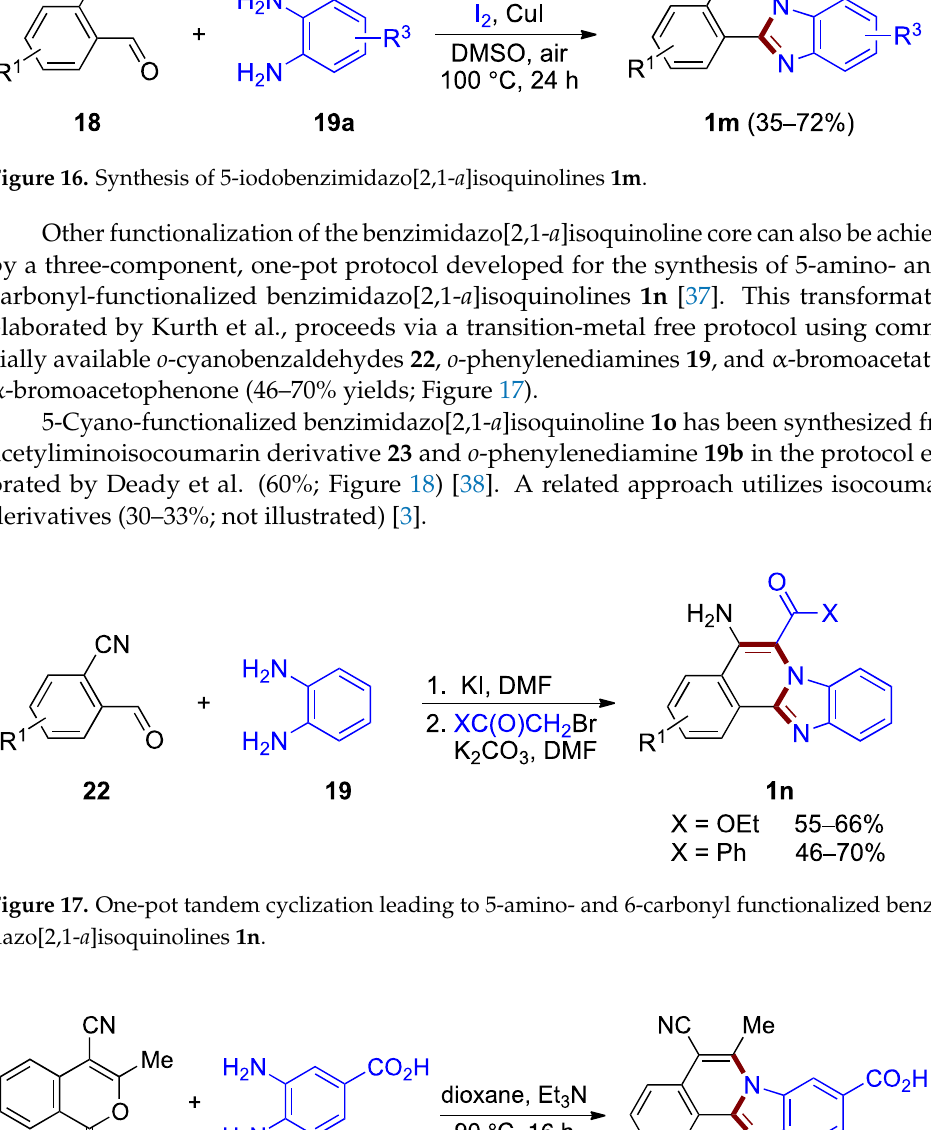
Figure 18. Reaction of acetyliminoisocoumarin 23 and o -phenylenediamine 19b .